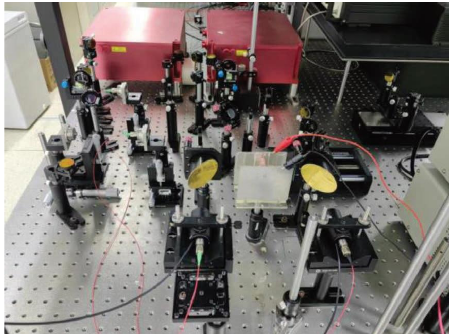
Figure 3: An overall photograph of the experimental device with EF